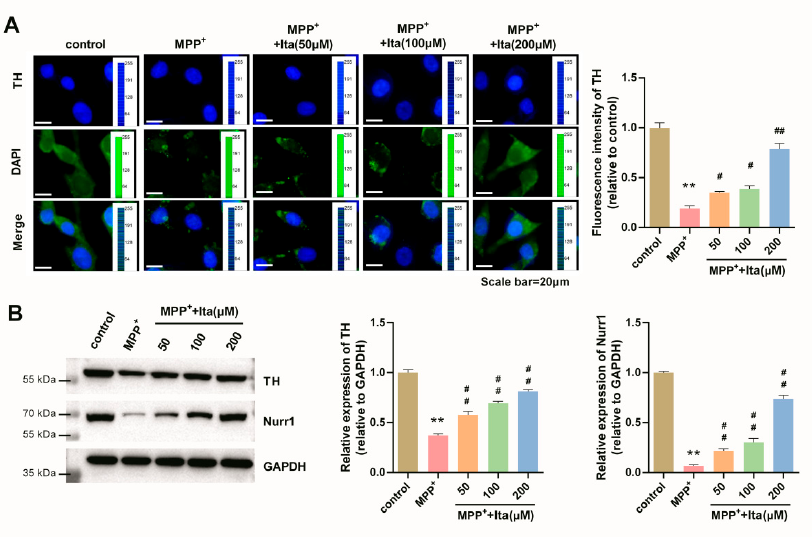
Figure 6. Itaconate attenuated dopamine neuronal damage in MPP + revulsive PD cell model. ( A ) The expression of TH was analyzed by immunofluorescence (magnification, × 400). The image acquisition parameters: image resolution ( − 4908 × 3264), objective (10 × ), and exposure settings (DAPI: 5 ms, TH: 200 ms). ( B ) The expression of TH and Nurr1 in MPP + revulsive PD cell model was measured by Western blotting. GAPDH serves as an internal control. n = 3. ** p < 0.01 vs. control group; # p < 0.05, ## p < 0.01 vs. MPP + group. GAPDH, glyceraldehyde-3-phosphate dehydrogenase; Ita, Itaconate.